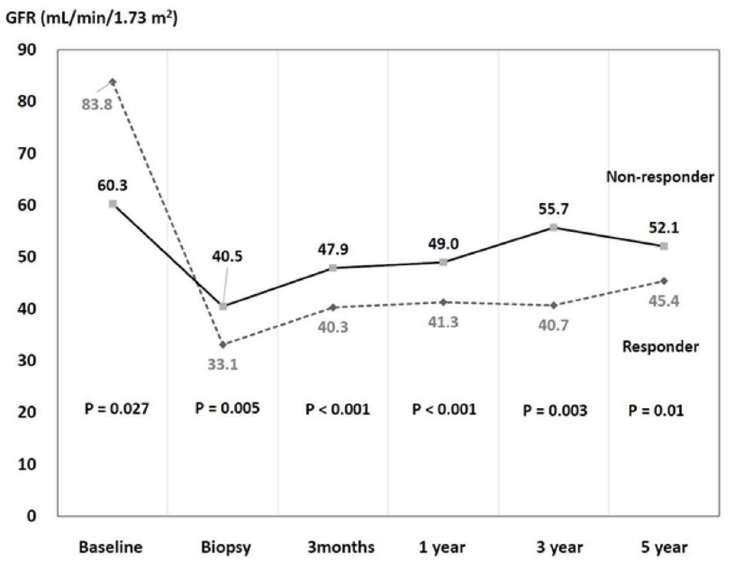
Fig 1. Changes in the estimated glomerular filtration